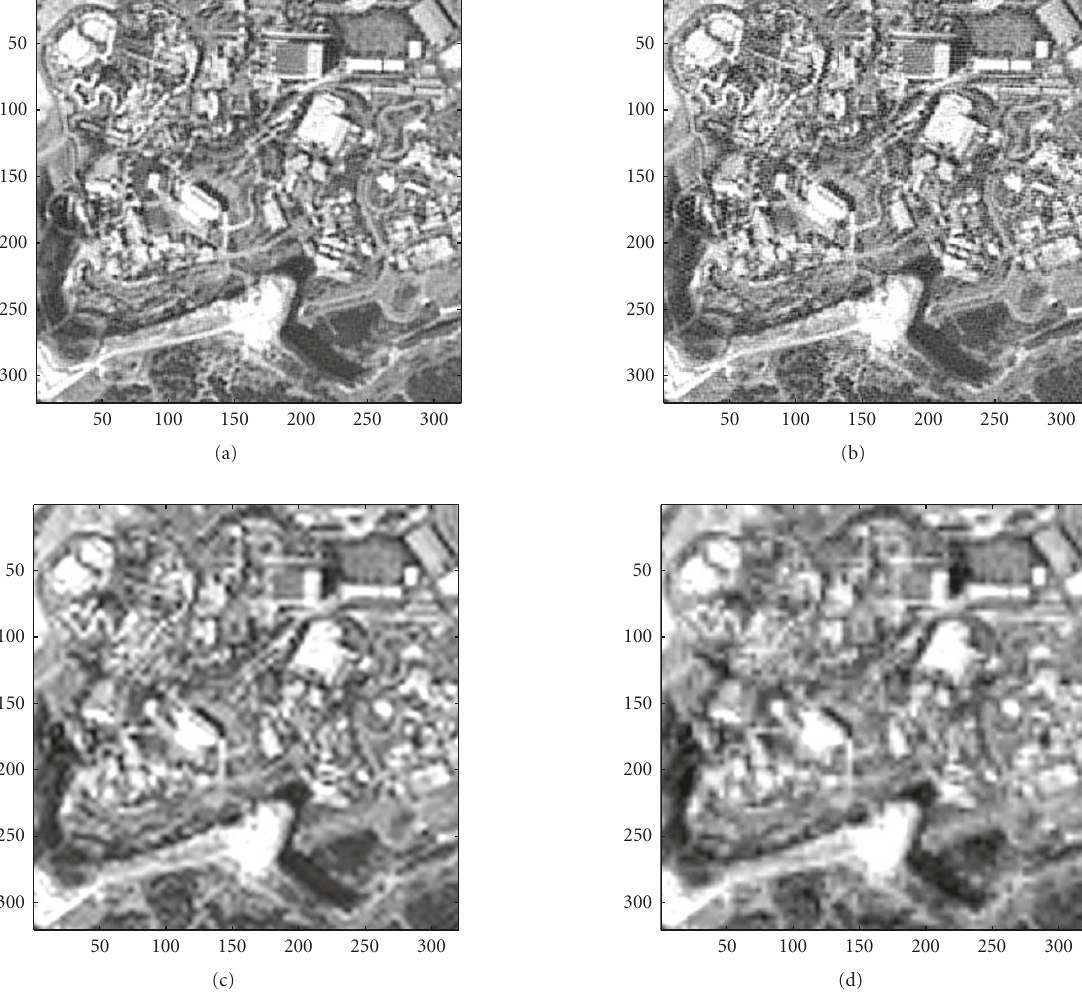
Figure 5: Simulated output HR image estimates for P = 5: (a) joint MAP SR-NUC; (b) MAP NUC followed by MAP SR; (c) MAP NUC followed by bilinear interpolation; (d) registration-based NUC followed by bilinear interpolation.